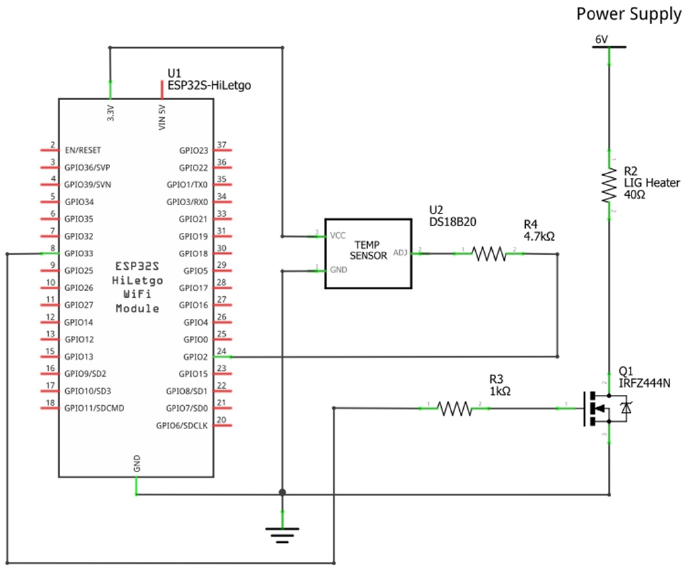
Figure 3. Schematic of the circuit design employed for the control of the LIG-based